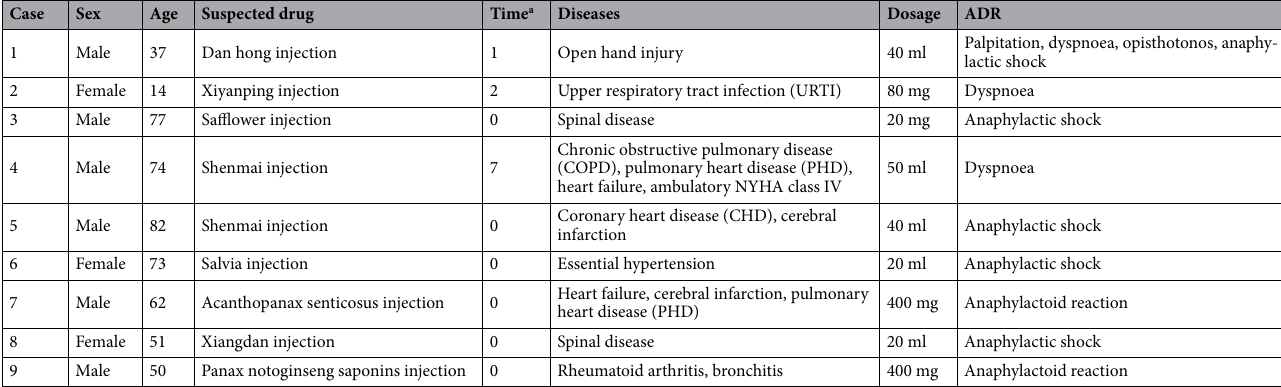
Table 7. Detailed information of the 9 deaths. a Time means the occurrence time of the ADRs.